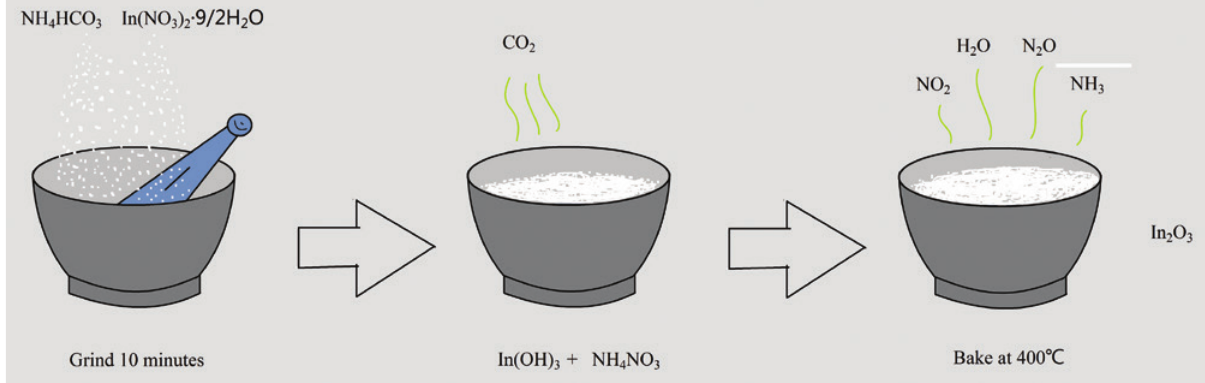
O nanoparticle preparation processes. 2 3